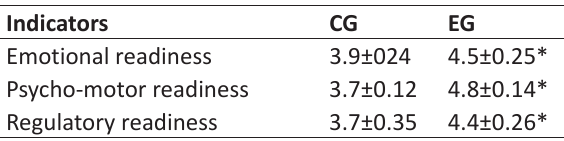
Table 1. Integral assessment of 55-60 age